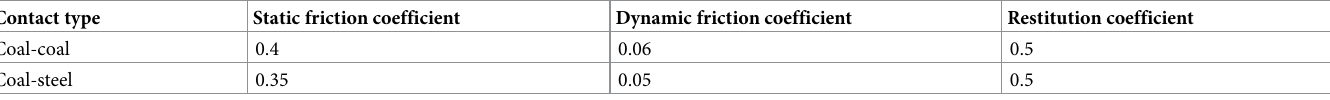
Table 5. Properties of the material contact.